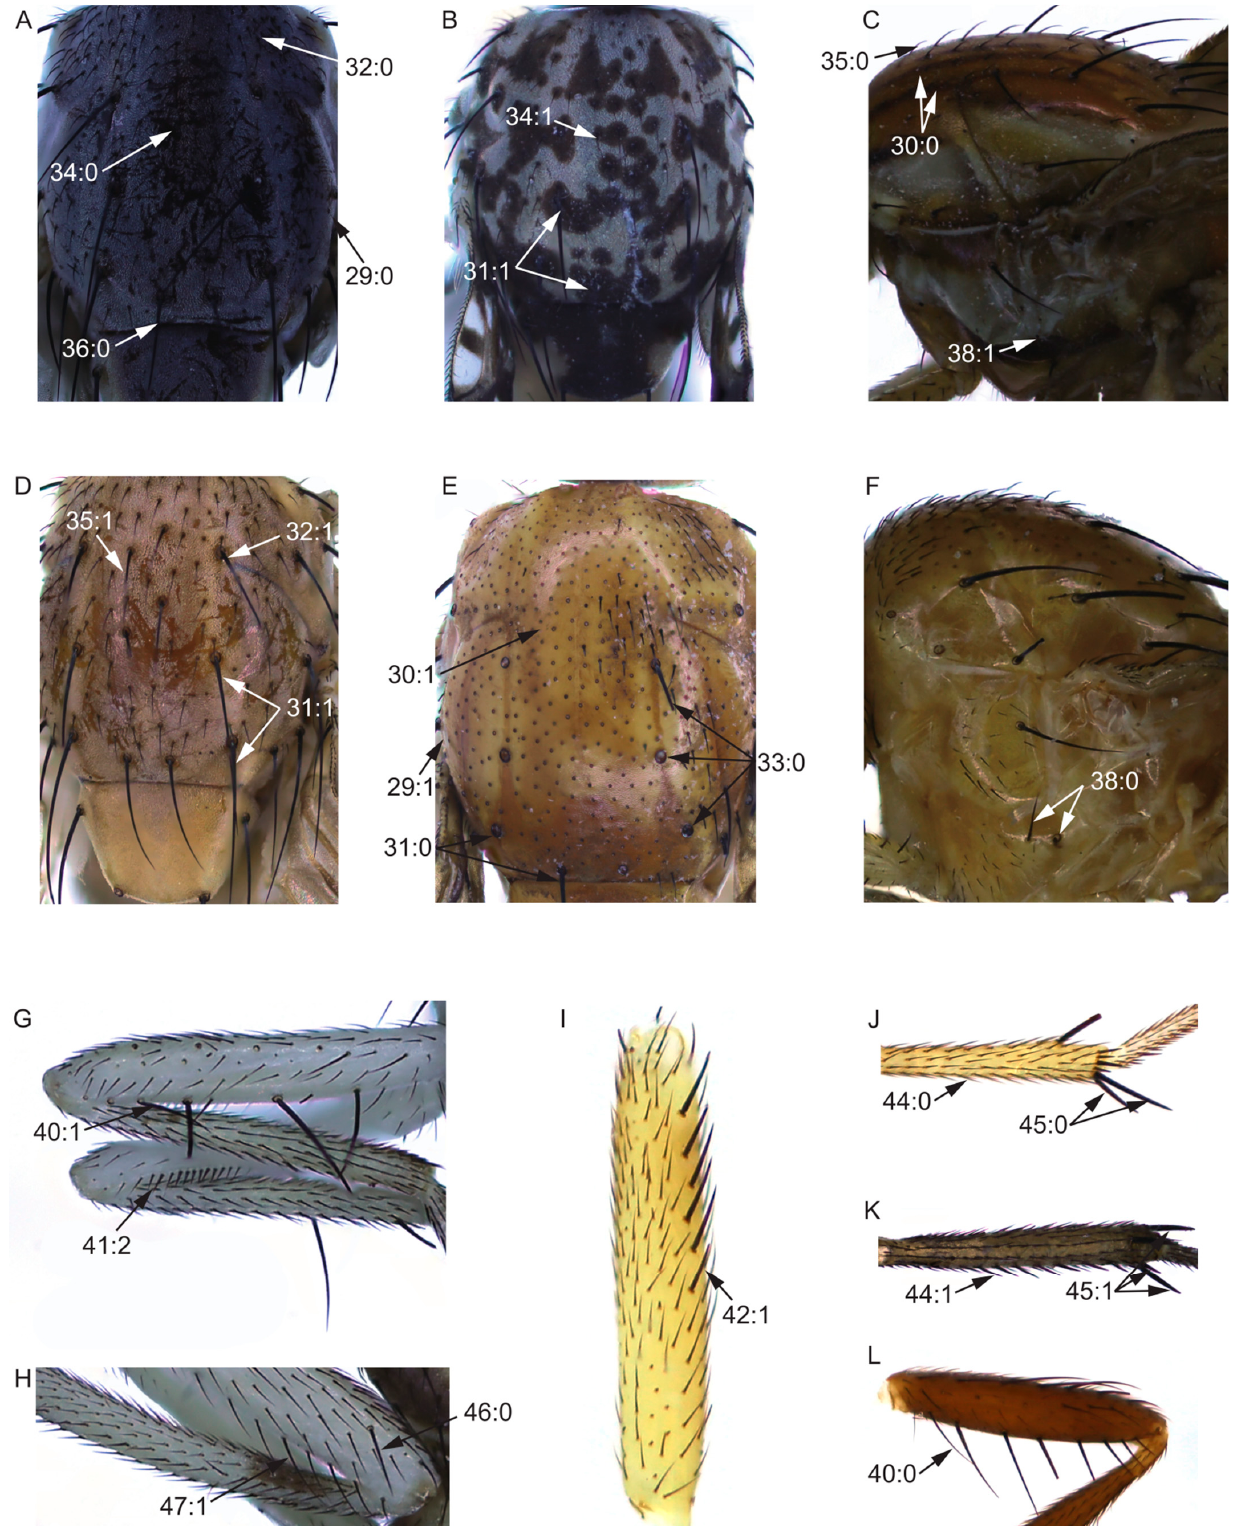
Figure 3. Thoracic and leg characters. ( A , G , H ): Homoneura ( Homoneura ) flavida ; ( B ): Homoneura ( Homoneura ) picta ; ( C ): Pachycerina decemlineata ; ( D , I , J ): Homoneura ( Euhomoneura ) yanqingensis ; ( E , K ): Homoneura ( Neohomoneura ) tricuspidata ; ( F ): Homoneura ( Minettioides ) orientis ; ( L ): Minettia ( Frendelia ) longipennis .